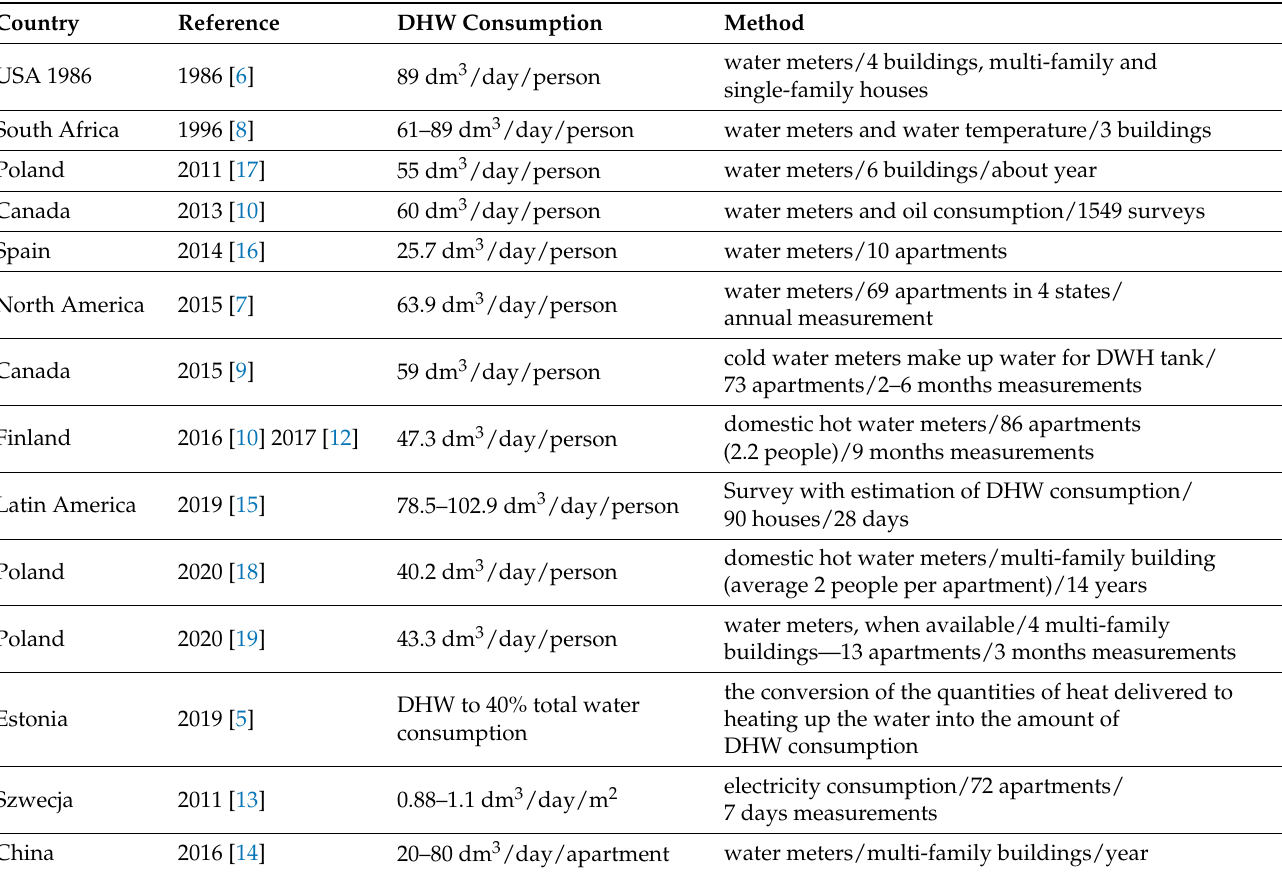
Table 1. Results of research on water consumption rates in residential buildings in the years